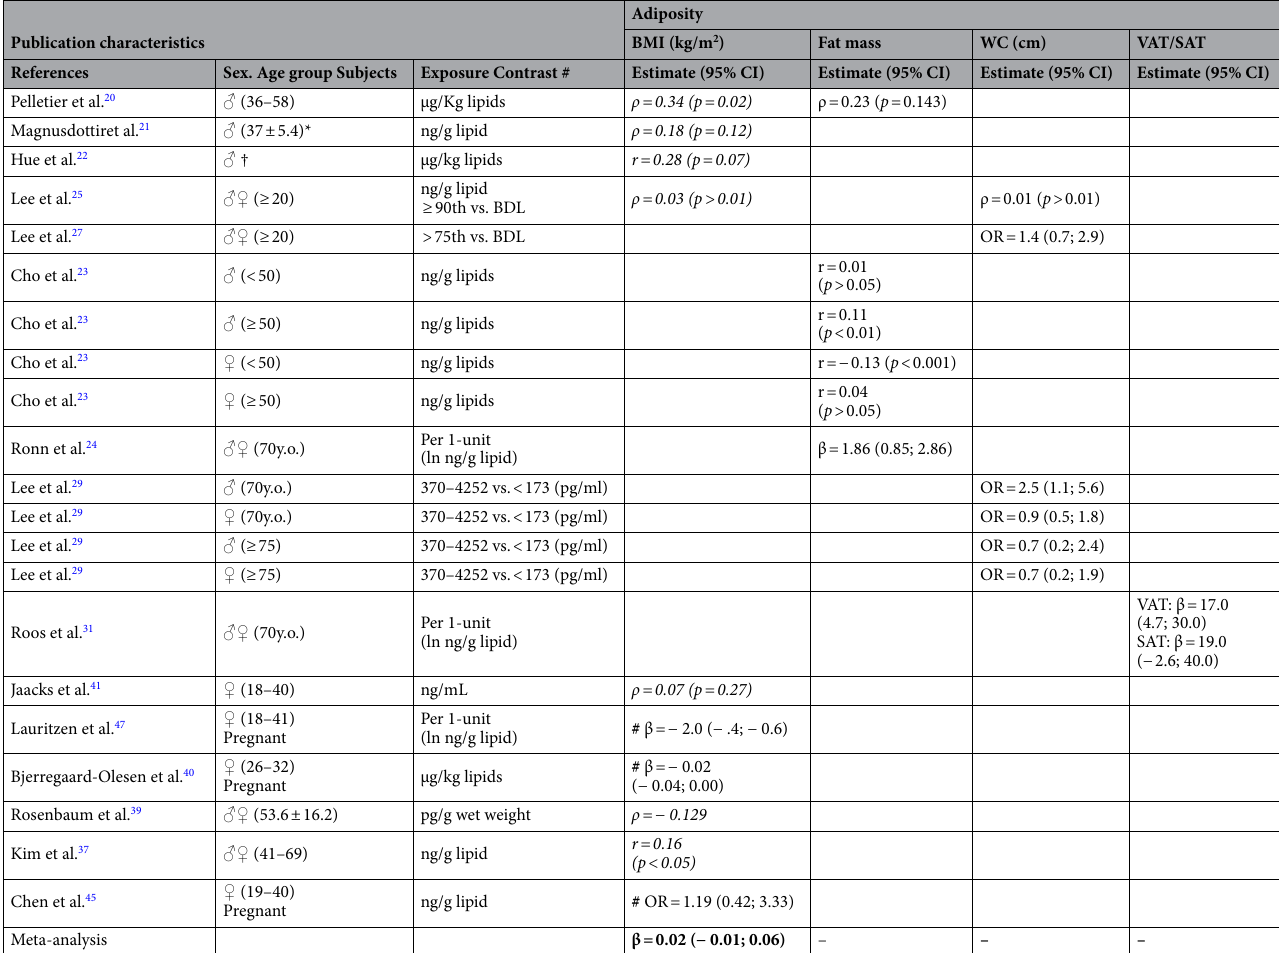
Table 2. Description of all found associations between trans-nonachlor and adiposity measures. BMI, Body Mass Index; WC, Waist Circumference;VAT, Visceral adipose tissue, SAT Subcutaneous adipose tissue; β, Beta coefficient; OR, Odds Ratio; ρ, spearmen correlation; r, Pearson correlation; * Mean; †, Without information; # Pre pregnancy-BMI as outcome; italic values represents studies for which was possible to perform a meta- analysis